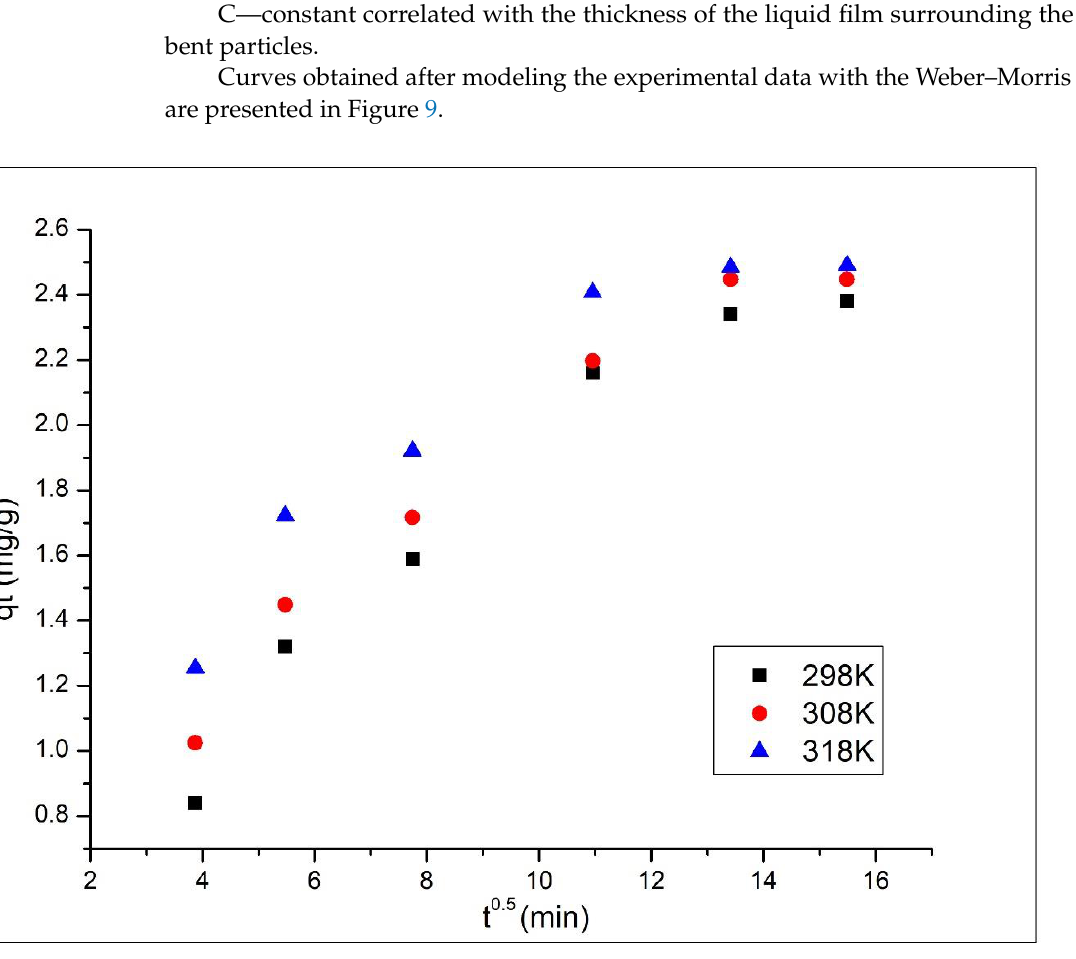
Figure 9. The intraparticle diffusion model parameters for the adsorption of Ru onto Ch-DB30C10 material at different temperatures.